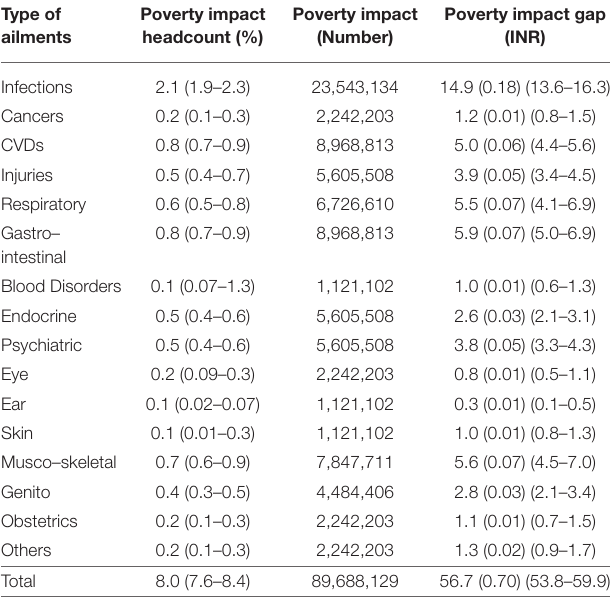
TABLE 2 | Poverty impact of morbidity in